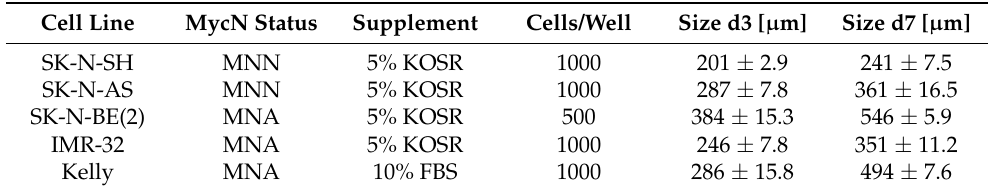
Table 1. Summary of optimal 3D culture conditions for fi ve neuroblastoma cell lines and average spheroid size (diameter) after 3 days (d3) and 7 days (d7) of culture growth. Cell Line